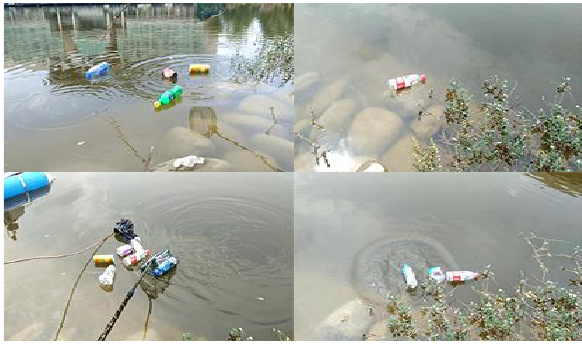
Figure 12. Sample images of the private dataset used in the experiments.